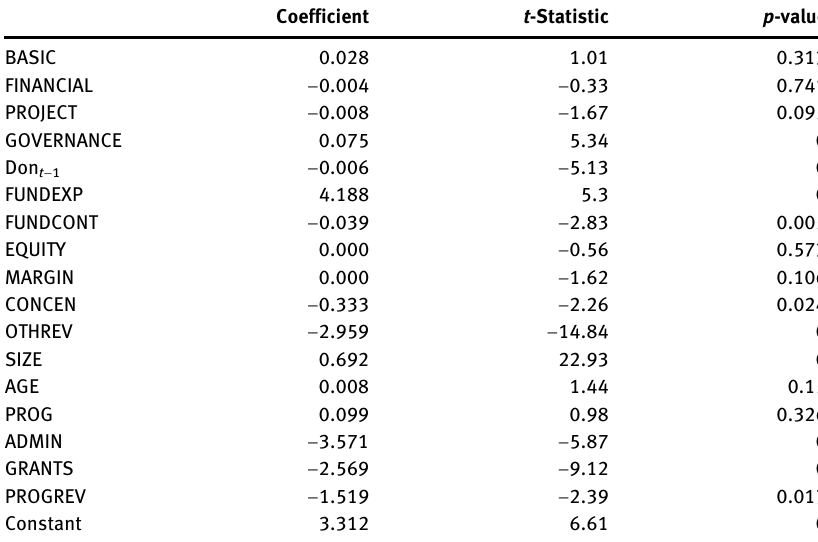
Table  : Robustness check – tobit